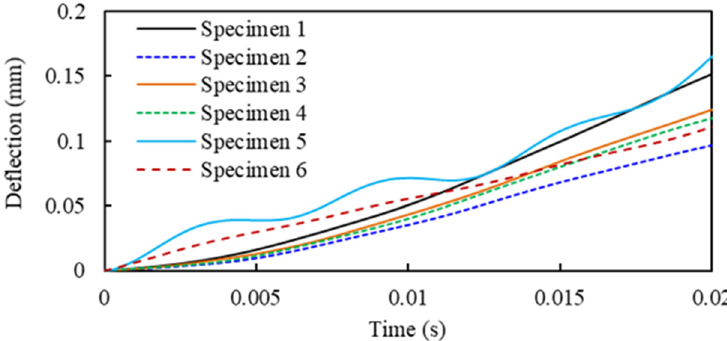
Figure 3. Deflection of CFRC slabs under an impact load.